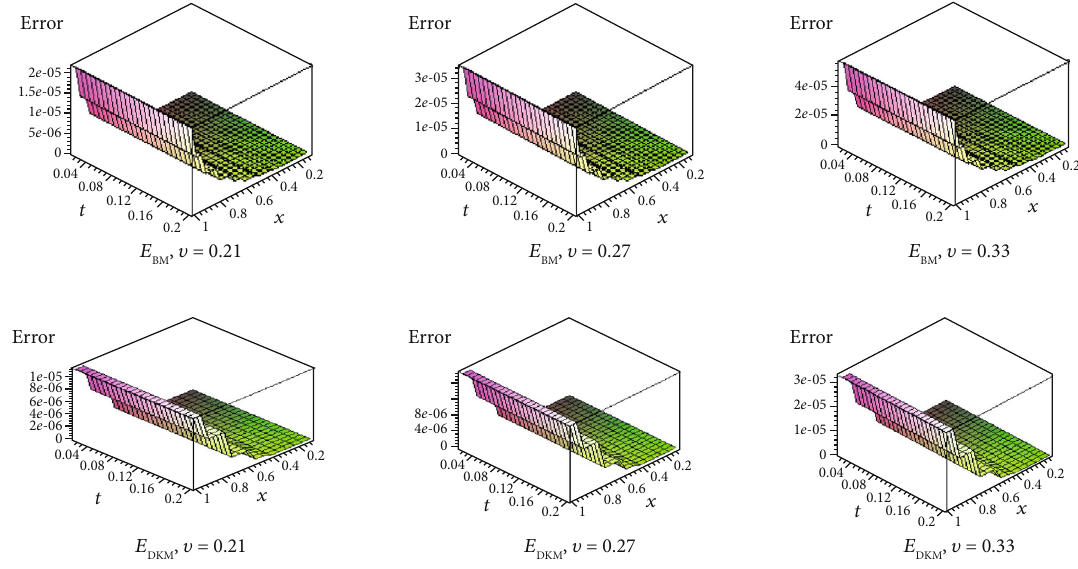
Figure 1: The values of errors by B-by-BM and DKM at T = 0 : 2 , N = 10 , and k = 1 for υ = 0 : 21, 0 : 27, 0 : 33 .